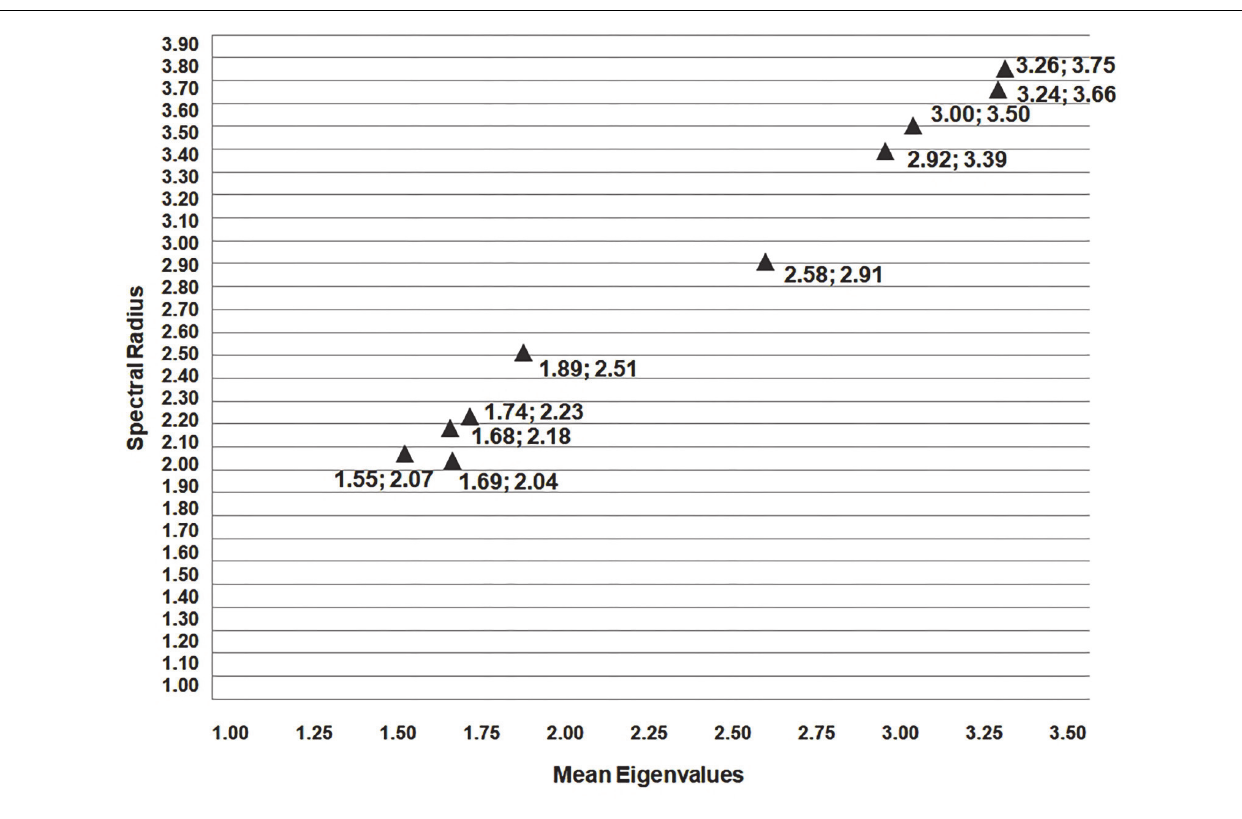
Frontiers in Physiology |